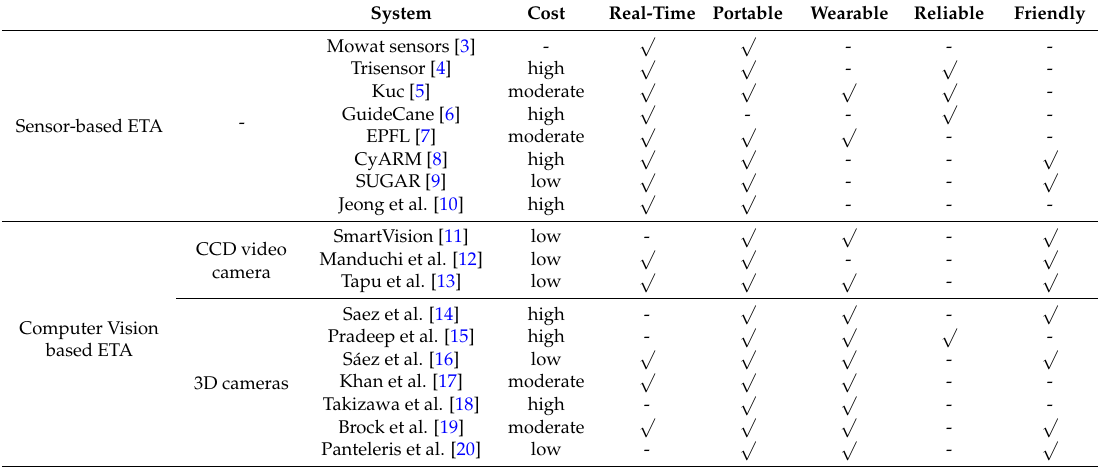
Table 1. Evaluation of the assistive device systems dedicated to visually impaired